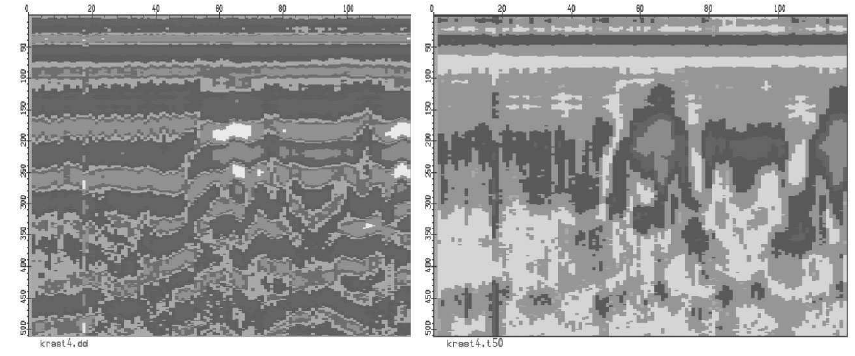
Figure 10. Subsurface radar sounding profile: before (left) and after (right) processing. Un- derground pipelines system.